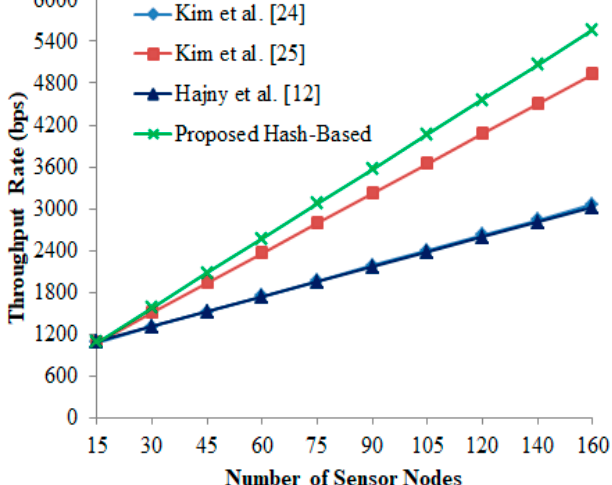
Figure 6. Throughput rate vs. number of sensor nodes.